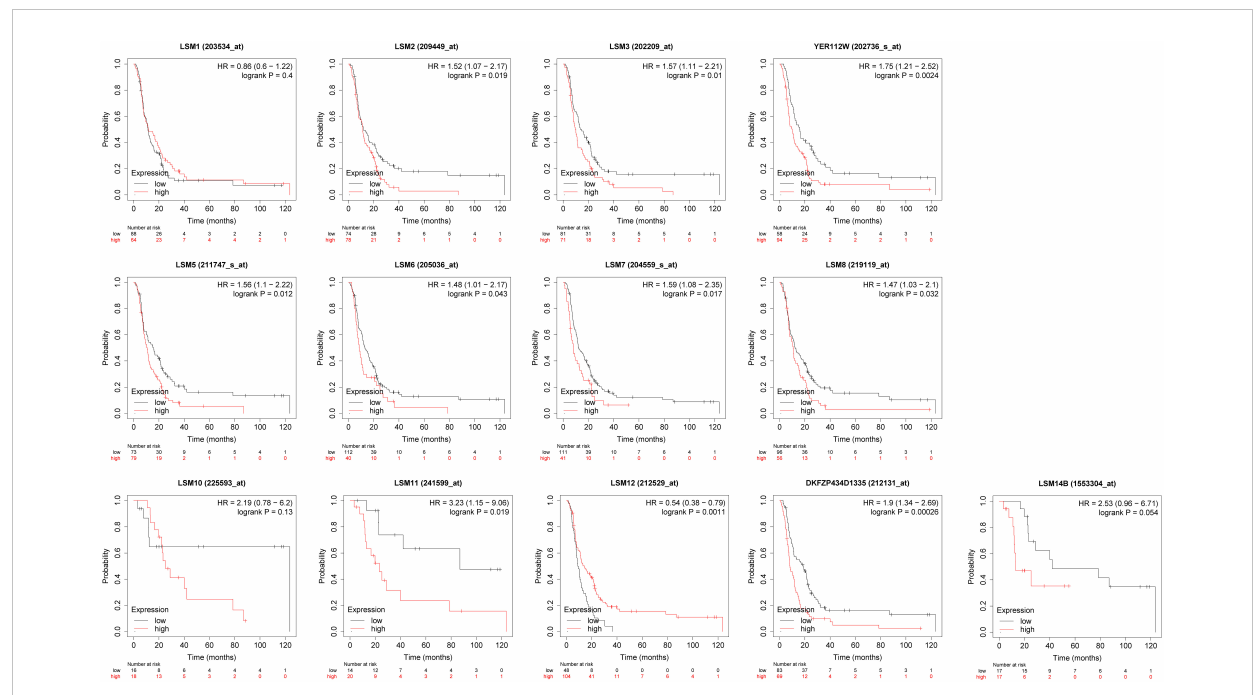
FIGURE 4 Prognostic value of LSMs in GC by Kaplan-Meier plotter. 9 of 13 members of the LSM family except LSM1, LSM10 and LSM14B were signi fi cantly associated with OS of GC patients with 5-FU chemotherapy from Kaplan-Meier Plotter